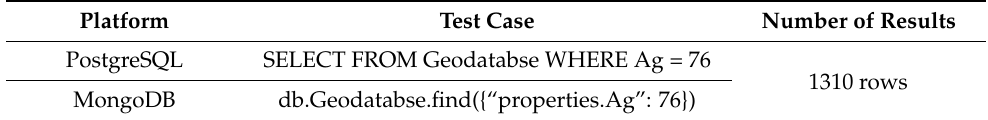
Figure 7. Relationship between the time consumption of geochemical data storage and number of features based on SSMG and SSPOG. Table 2. Test case of